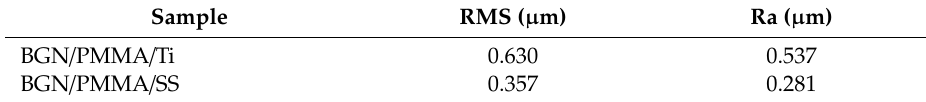
Figure 7. AFM images of thin films after immersion in SBF: ( a ) BGN / PMMA / Ti, ( b ) BGN / PMMA / SS. Table 3. The roughness values of analyzed thin films after immersion in